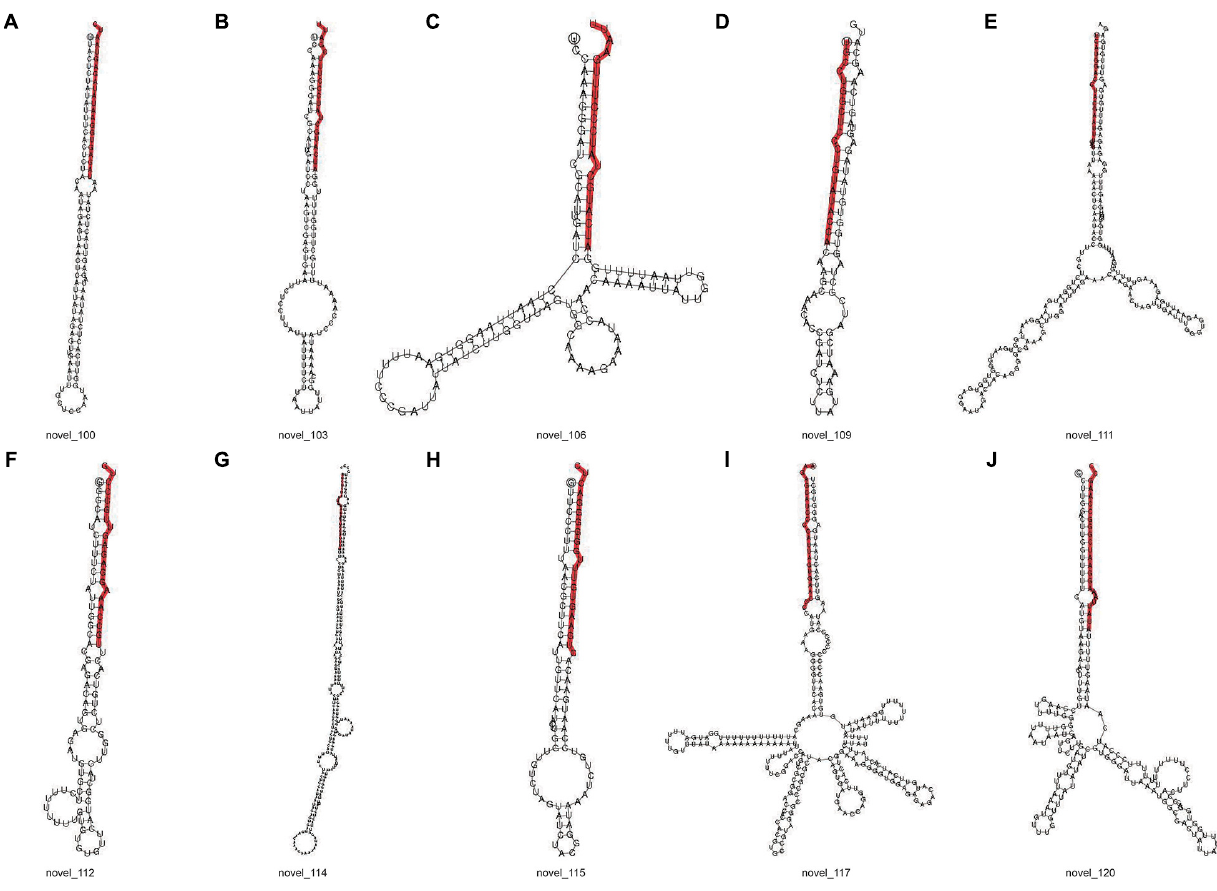
Frontiers in Genetics |